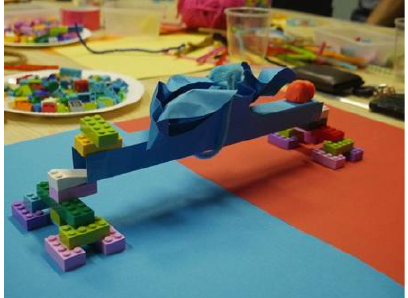
Figure 4. The giant bridge (source: created by